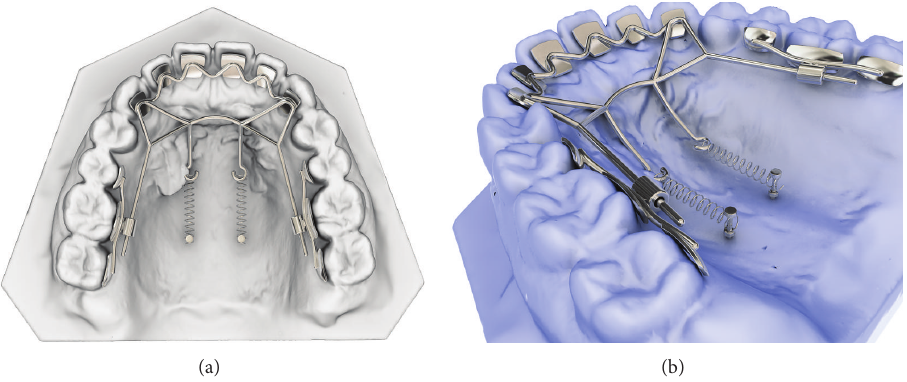
Figure 1: The newly designed lingual retraction system; kinematics of lingual bar on nonparalleling technique (KILBON appliance). The anterior segment is made of lingual pads-wire and lever arms for retraction of the anteriors. Posterior segment has a short tube where guide wire of anterior segment slides